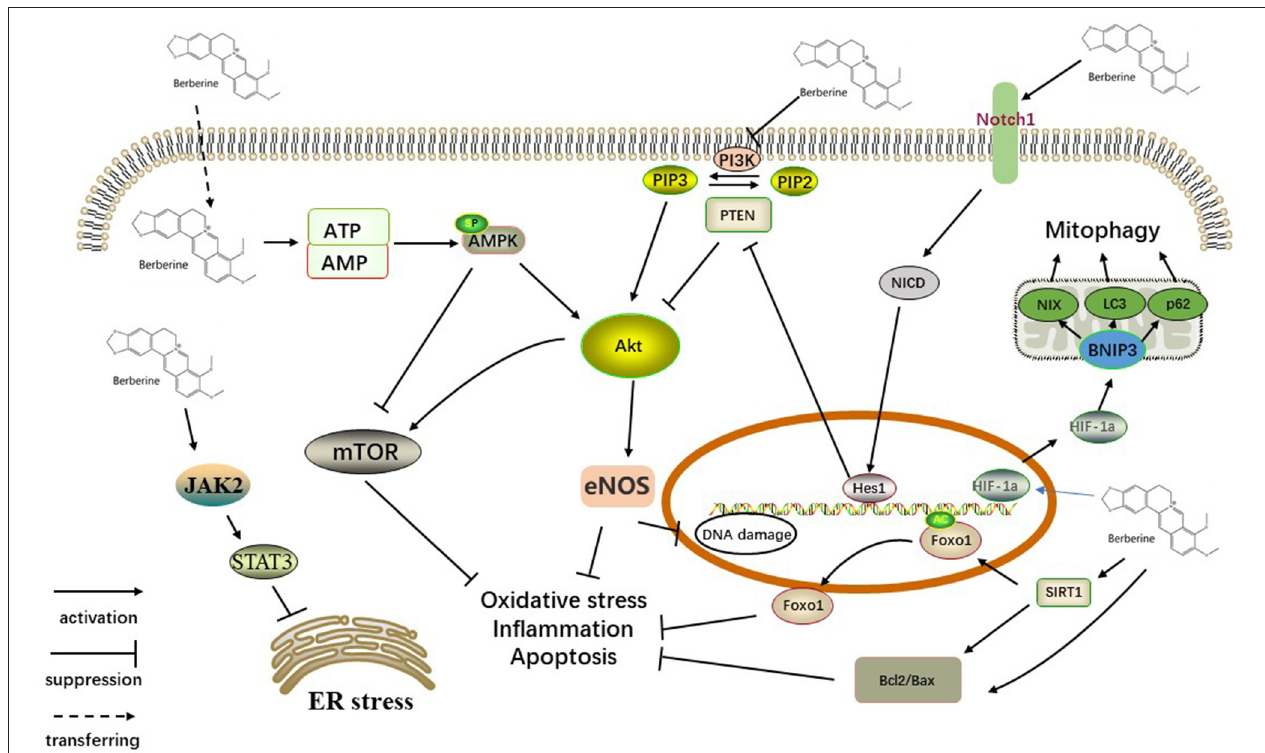
FIGURE 13 | Schematic representation of BBR in cardiac myocytes. BBR upregulated expression of NICD and Hes1 by activating Notch1, which is distributed on the cell membrane. PTEN/Akt, the downstream signaling pathway, also participates in this process. Activation of the SIRT1/FOXO signaling pathway might also play a key role in the antiapoptotic action of BBR. BBR activates AMPK and other pathways that inhibited the Akt pathway, further acting on the mTOR factor. In addition, activating JAK2/STAT3 signaling participates in the action of BBR on ER stress. BBR also promotes mitophagy via the HIF-1 α /BNIP3 pathway. SIRT1, silent information regulator 1; FOXO, forkhead box O; ER, endoplasmic reticulum stress, JAK, Janus kinase; STAT, signal transducer and activator of transcription; PI3K, phosphoinositide 3-kinase; PIP2, phosphatidylinositol-4,5-bisphosphate; PIP3, phosphatidylinositol 3,4,5-triphosphate; PTEN, phosphatase and tensin homolog; AKT, protein kinase B; eNOS, endothelial nitric oxide synthase; mTOR, mammalian/mechanistic target of rapamycin; AMPK, AMP-activated protein kinase; ATP/AMP, adenosine triphosphate/adenosine monophosphate; Hes1, hairy and enhancer of split 1; NICD, Notch intracellular domain; HIF-1 α , hypoxia inducible factor-1 α ; NIX,